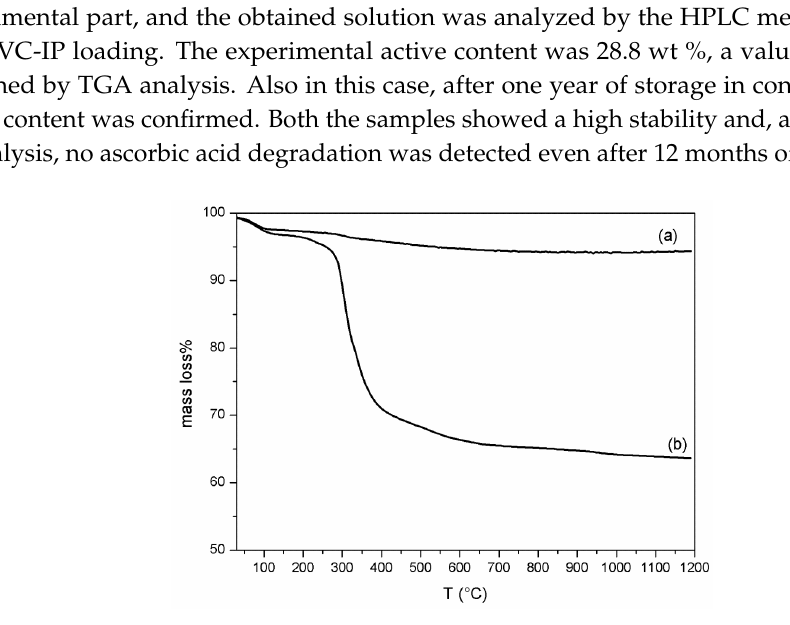
Figure 5. TGA of SBA-15 ( a ) and VC-IP@SBA-15 ( b ).